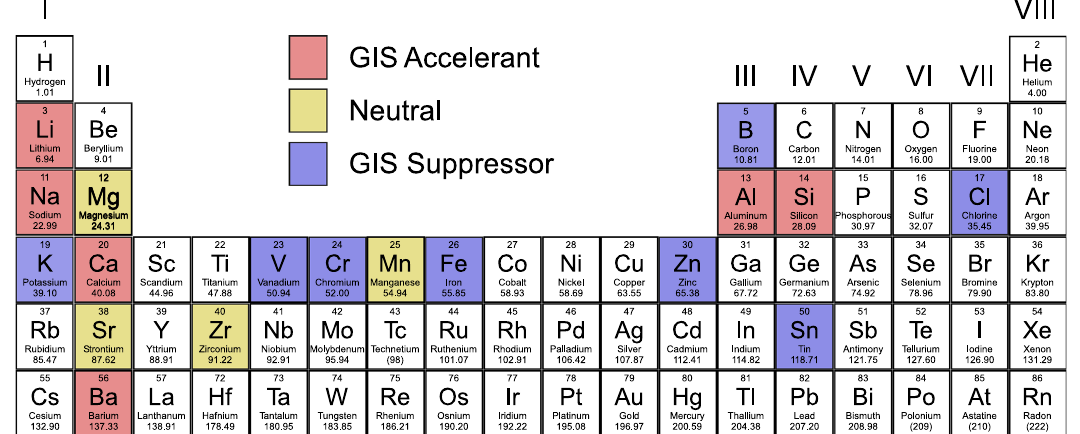
Fig. 1 Periodic table. Effect of elemental species on zeolite GIS crystallization rates using conventional synthesis conditions. Each synthesis was carried out for 3 days at 100 °C using a growth mixture with a molar composition of 9 SiO 2 :0.5 Al 2 O 3 :5.5 Na 2 O:0.2 M x O y :190 H 2 O. Growth mixtures have a pH value of ~13. Reagent “ M ” corresponds to the element added (see the “ Materials ” section for details), which is color-coded according to its effect on the crystallization rate: accelerant (red), suppressor (blue), or neutral